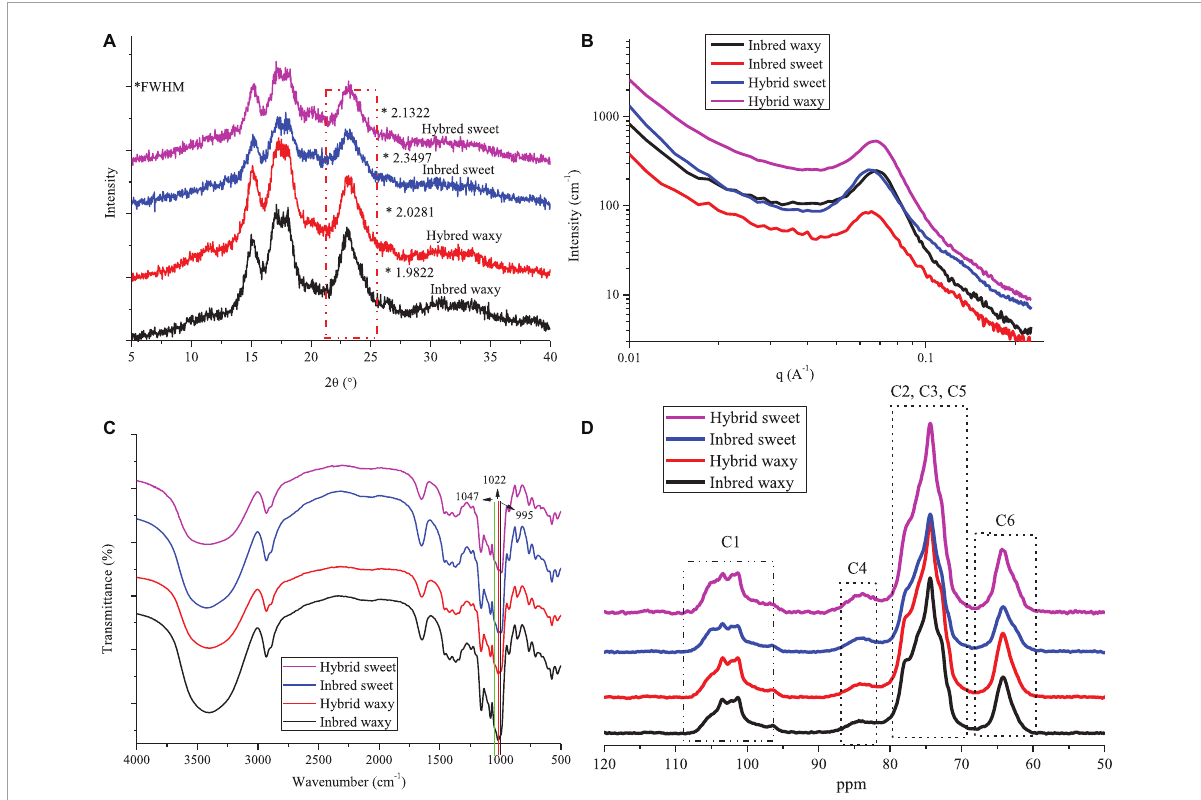
FIGURE3 X-ray diffraction (XRD), small-angle X-ray scattering (SAXS), FTIR, and 13 C CP/MAS NMR of starch from waxy, sweet, and hybrid sorghum. (A) XRD; (B) SAXS; (C) FTIR; and (D) 13 C CP/MAS NMR.